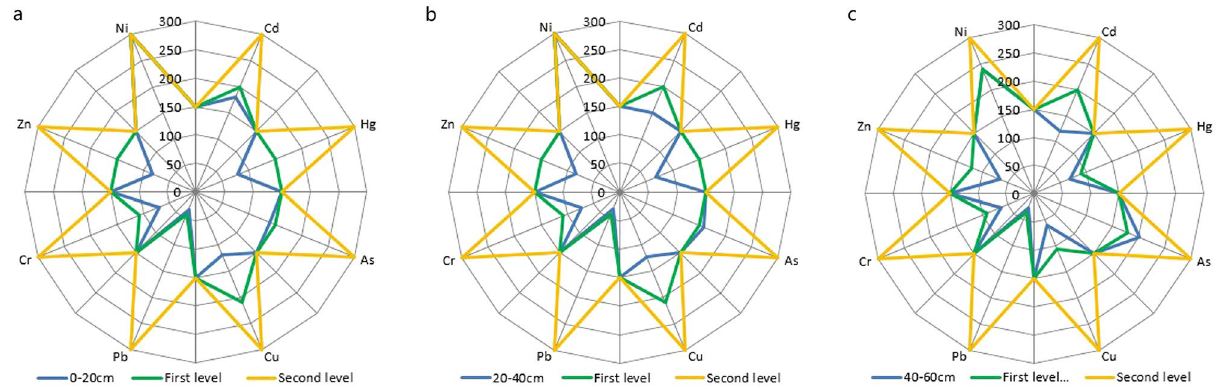
Figure 2. Environmental quality equal intercept transformation radar chart of the soil in the hilly